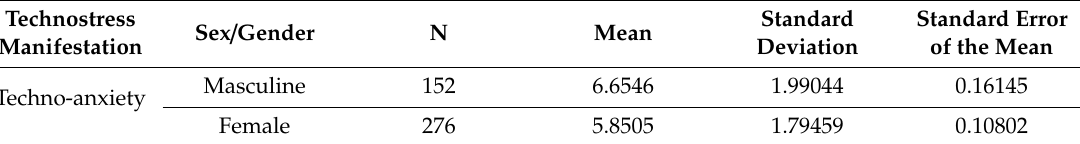
Table 2. Techno-anxiety statistics by gender.